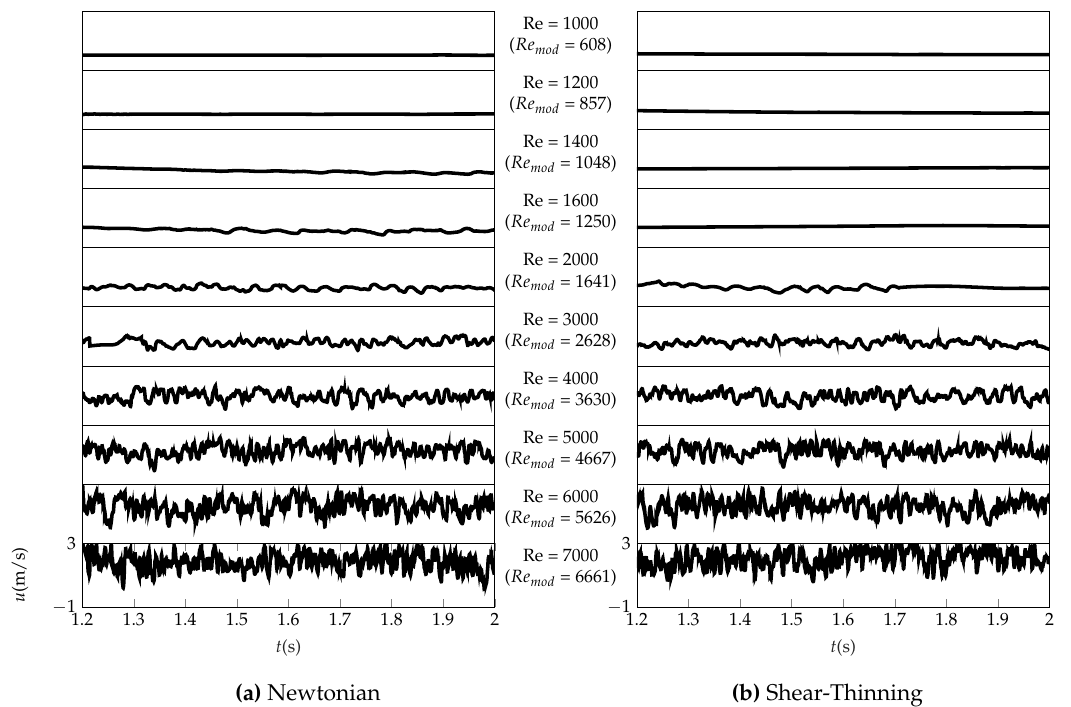
Figure 11. Monitoring of velocity magnitude through time of Newtonian blood (a) and shear-thinning blood (b) at point x / S = 6.13, y / S = 0 and z / S = 0. blood ( b ) at point x / S = 6.13, y / S = 0 and z / S =